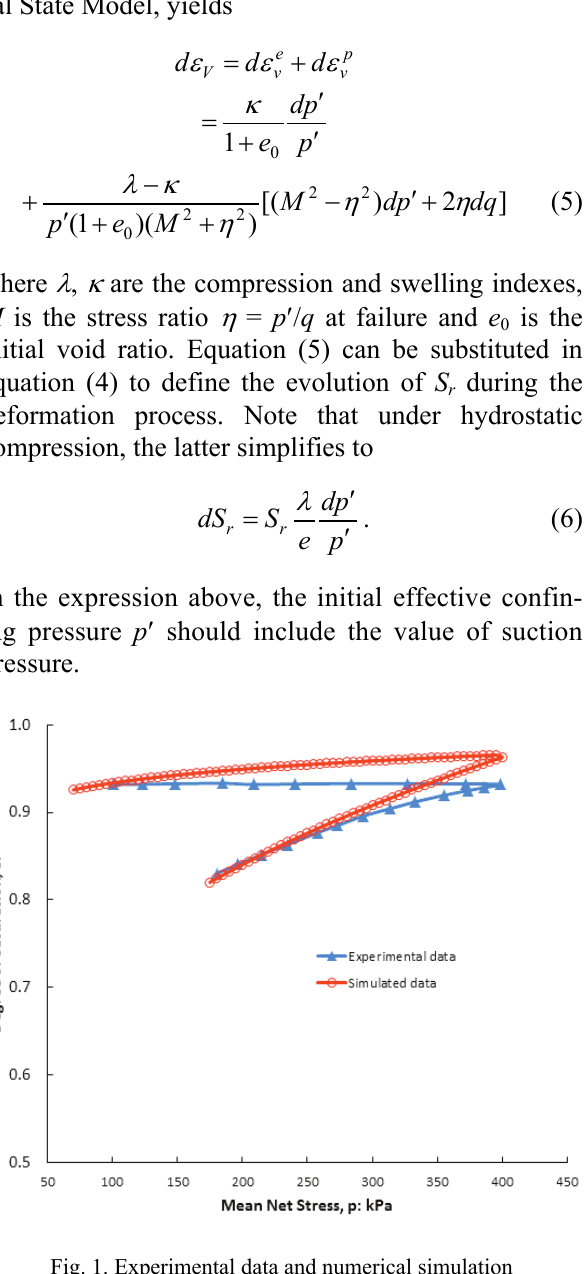
Fig. 1. Experimental data and numerical simulation of isotropic compression test at constant suction